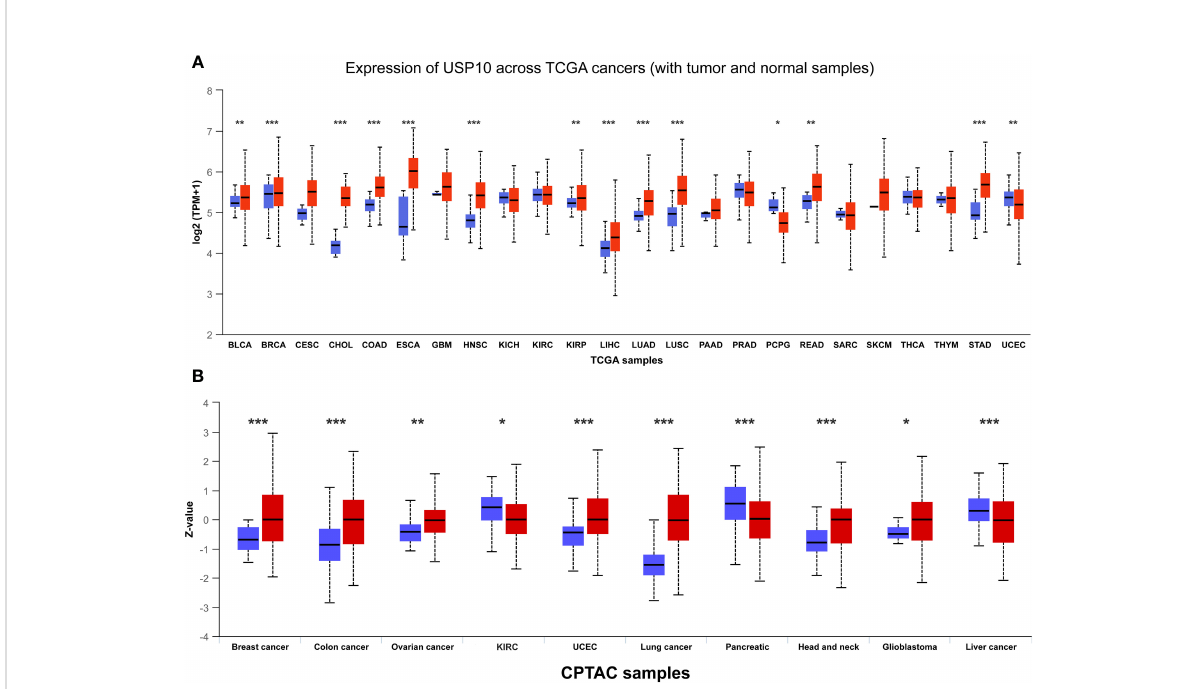
FIGURE 2 The gene and protein expressions of USP10 in pan-cancers based on TCGA and CPTAC databases. (A) The gene expressions of USP10 in pan-cancers based on TCGA database; (B) The protein expressions of USP10 in pan-cancers based on CPTAC database. Red color: tumor